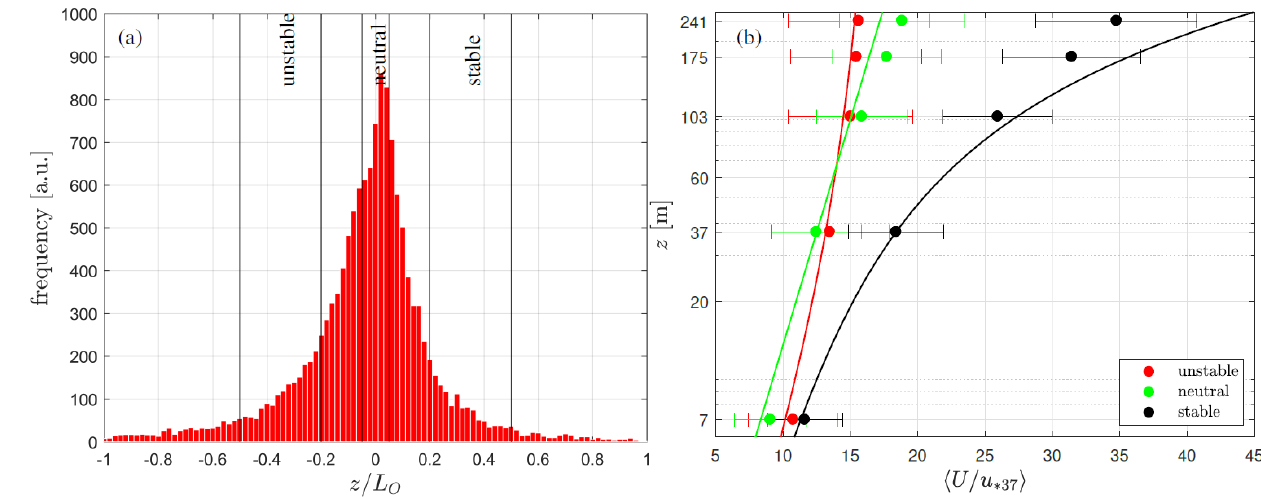
Figure 1. (a) Frequency of atmospheric stability conditions observed at Østerild within the close-to-homogeneous sector. (b) Normalized vertical wind profiles under different stability conditions. Observations are shown in markers and Monin–Obukhov similarity theory (MOST) profiles in solid lines (see details in the text). The error bars denote ± 1 standard deviation.